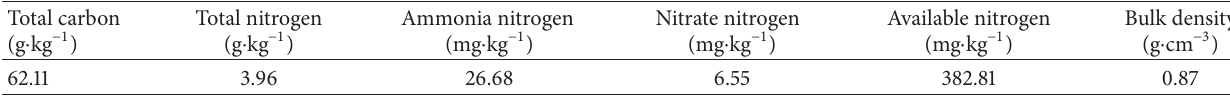
Table 1: Basic physical and chemical properties of studied